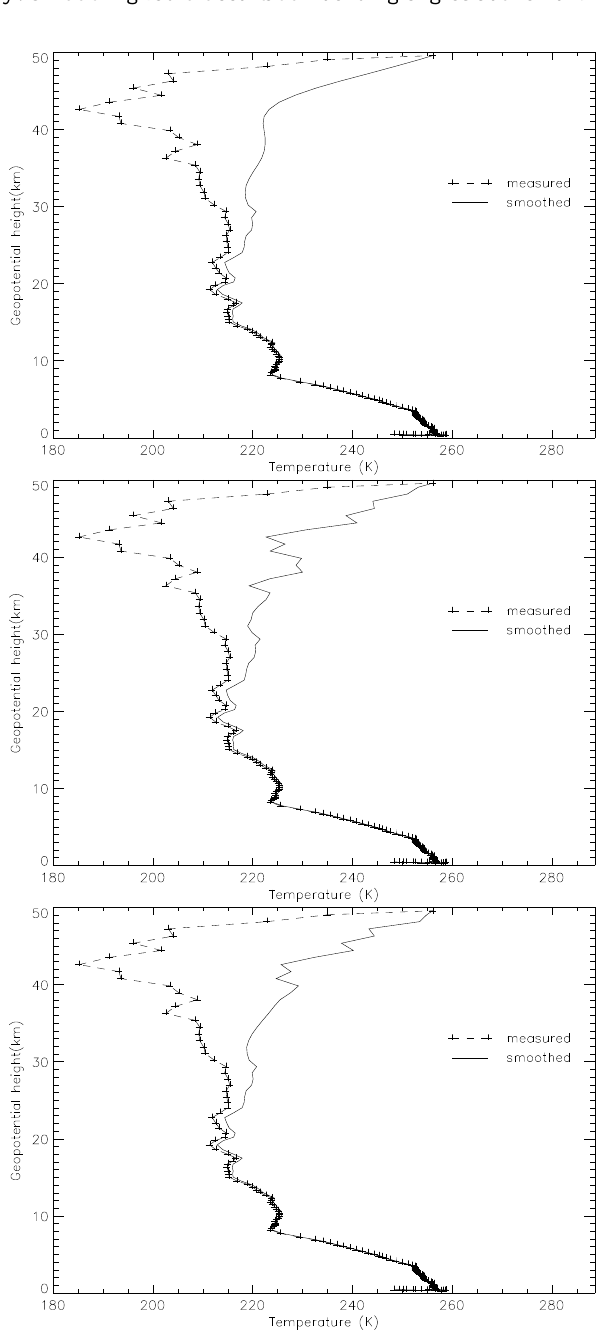
Fig. 5. The retrieved temperature profiles corresponding to the smoothed bending angle profiles given in Fig.